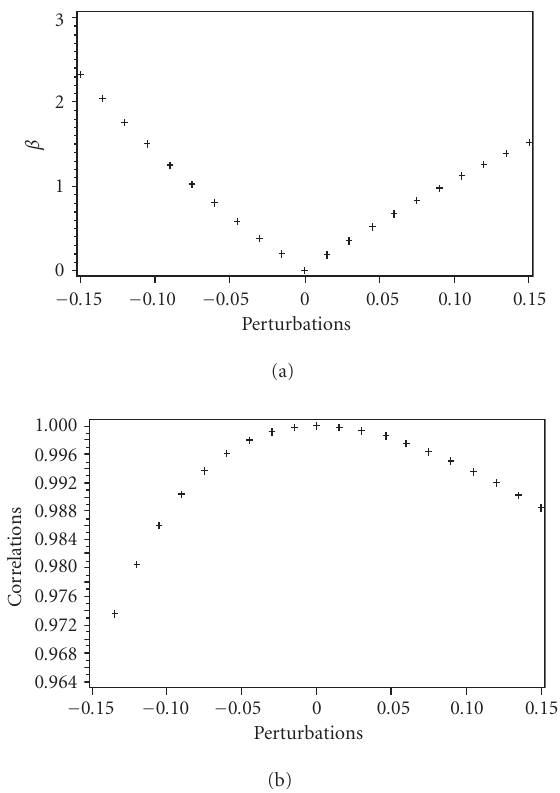
Figure 2. (a) Univariable synthesis method—e ff ect of perturb- ing b u 2 on partial regression coe ffi cients. The x -axis represents the perturbation; the y -axis represents the change in the regres- sion coe ffi cient in standardized distance between the perturbed and unperturbed models. (b) Univariable synthesis method— e ff ect of perturbing b u 2 on correlations. The x -axis represents the perturbation; the y -axis represents the correlation between the predicted values for the perturbed and unperturbed models.